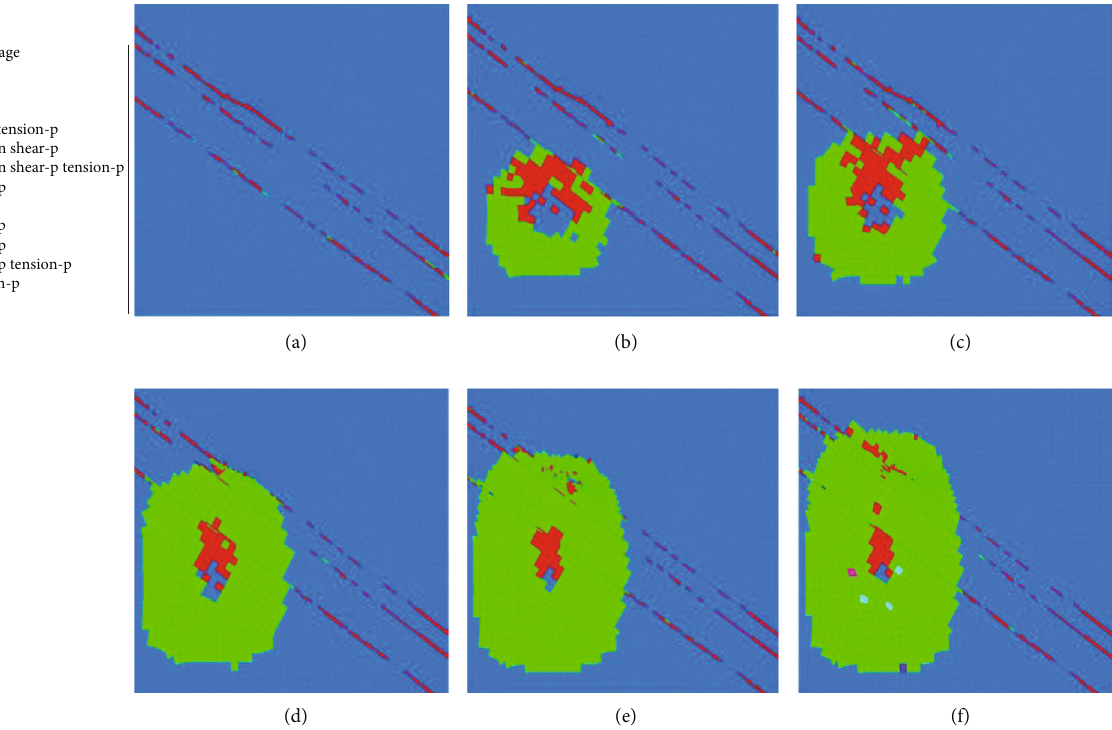
Figure 12: Plastic zone of 3 coal roadway fl oor during advancing of 97308 working face. (a) Working face advancing 120 m; (b) working face advancing 160m; (c) working face advancing 200 m; (d) working face advancing 240 m; (e) working face advancing 280m; (f) working face advance over 280 m.